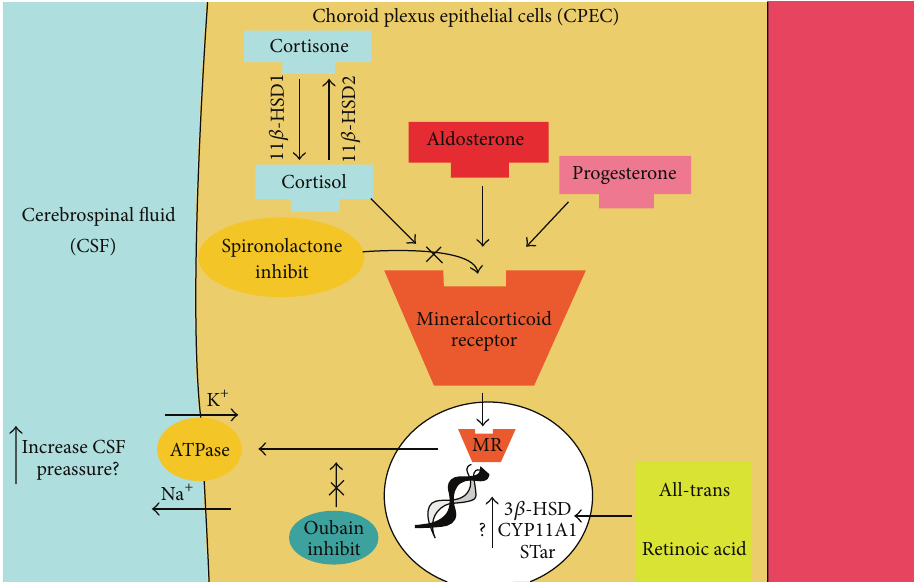
Figure3:TheputativeeffectsofawidearrayofneuroendocrineinteractionsonCSFsecretioninthechoroidplexusepithelium.Detailedfigure of CP epithelium illustrating the proposed regulation of CSF secretion by several neuroendocrine interactions. Aldosterone can stimulate MR. In nucleus MR can activate mineralocorticoid responsive elements that stimulate synthesis from DNA of Na + /K + ATPase pumps. Active sodium secretion by the Na/K ATPase at the apical CP membrane lead to movement of sodium ions into the cerebral ventricle and this creates an osmotic gradient to drive CSF secretion. The enzyme 11 𝛽 HSD1 is highly abundant in the CP, in which its oxidoreductase activity converts inactive cortisone to cortisol, which can activate the MR with similar affinity to aldosterone. All-trans retinoic acid, interacting with DNA, can activate neurosteroidogenesis and de novo synthesis of steroids. CPEC = choroid plexus epithelial cells; CSF = cerebrospinal fluid; MR = mineralcorticoid receptor; CSF = cerebrospinal fluid; see [50] (http://www.ncbi.nlm.nih.gov/pubmed/23160227).